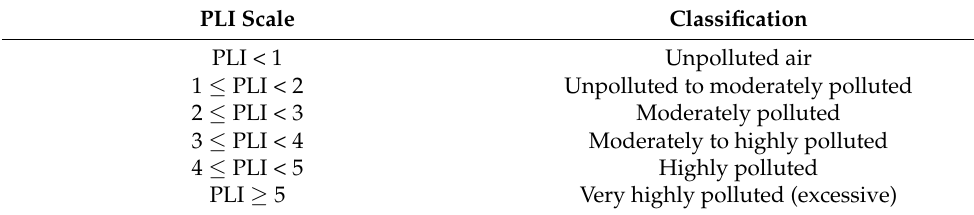
Table 2. Classification of the pollution load